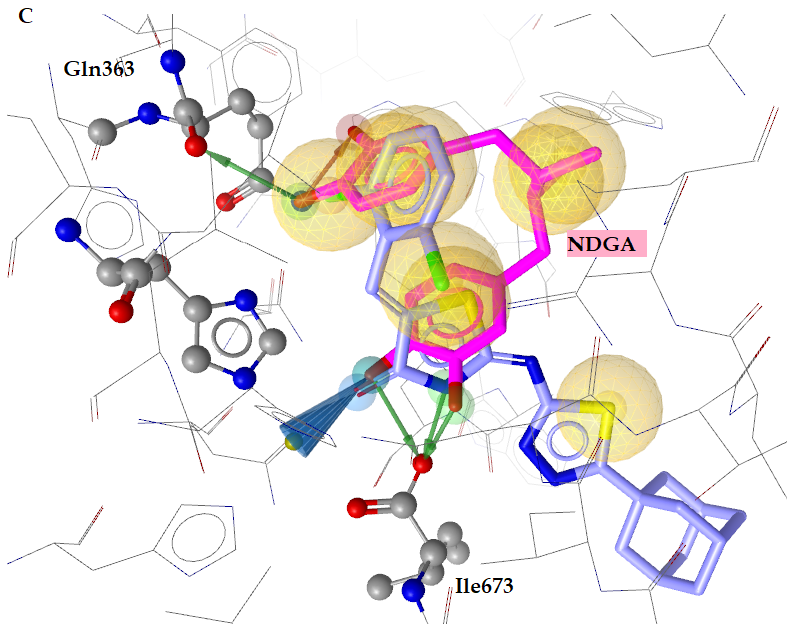
Figure 6. ( A ) Two-dimensional interaction diagram of the reference compound NDGA in 5-LOX. ( B ) Two-dimensional interaction diagram of compound 14 in 5-LOX. ( C ) Superposition of compound 14 (blue) bound to 5-LOX by comparison with NDGA (magenta), with labeled specific residues. Active site zinc revealed as yellow small sphere, green and red dotted arrows illustrate hydrogen bond, pink dotted arrows represent halogen bond and yellow sphere hydrophobic interactions.